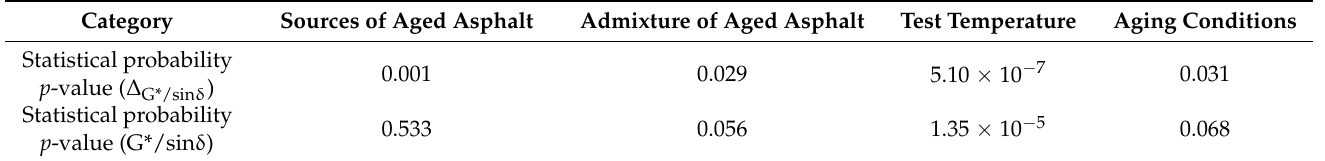
Table 5. Analysis of variance results for reclaimed asphalt Δ G*/sinδ and G*/sinδ.